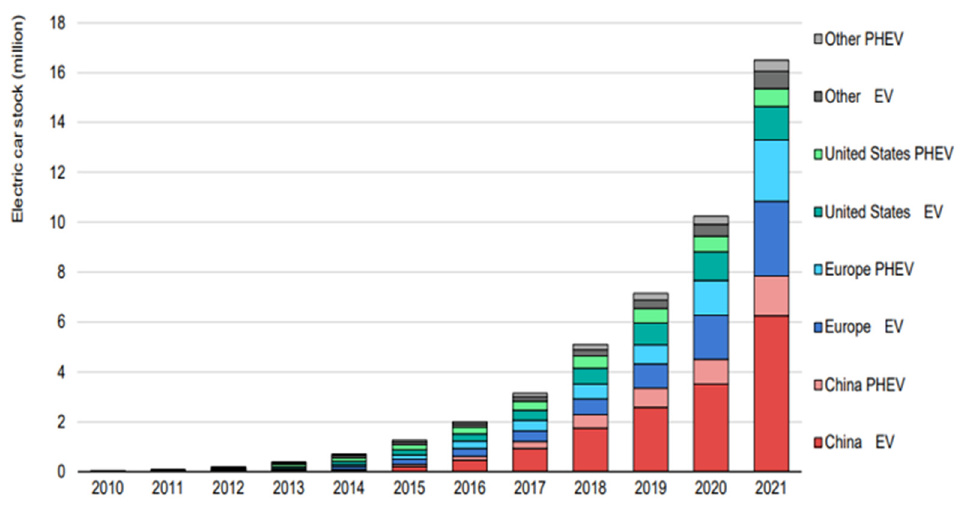
Figure 3. Electric cars on the world’s roads in 2021 [45].